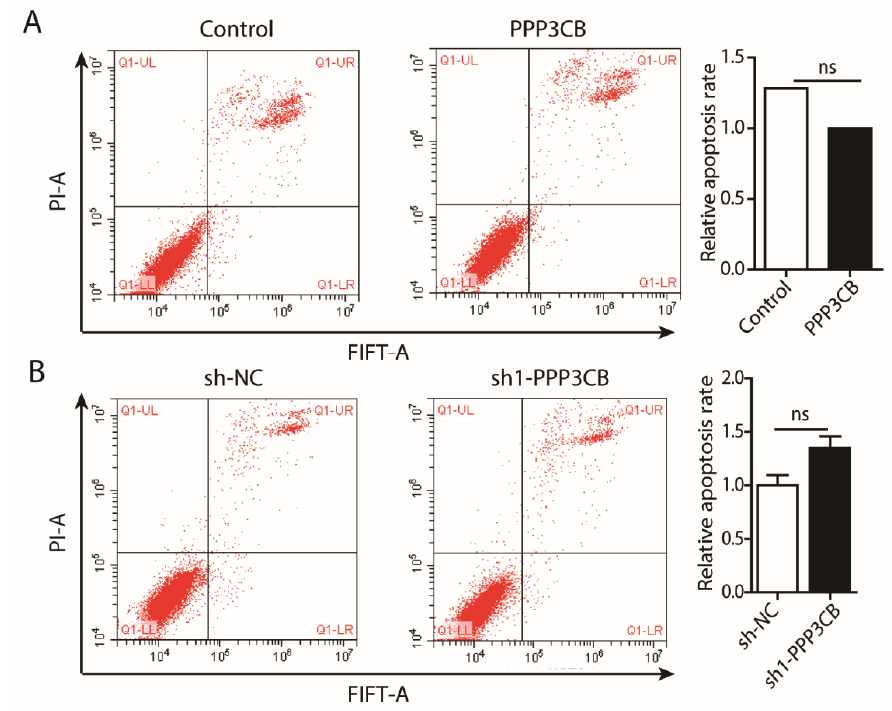
Figure A2. PPP3CB has no effect on apoptosis of G401 cells. ( A , B ) Flow cytometric analysis of cells apoptosis after fluoresceine isothiocyanate (FITC)and propidium iodide(PI) staining. Data presents mean ± SEM from three independent experiments.